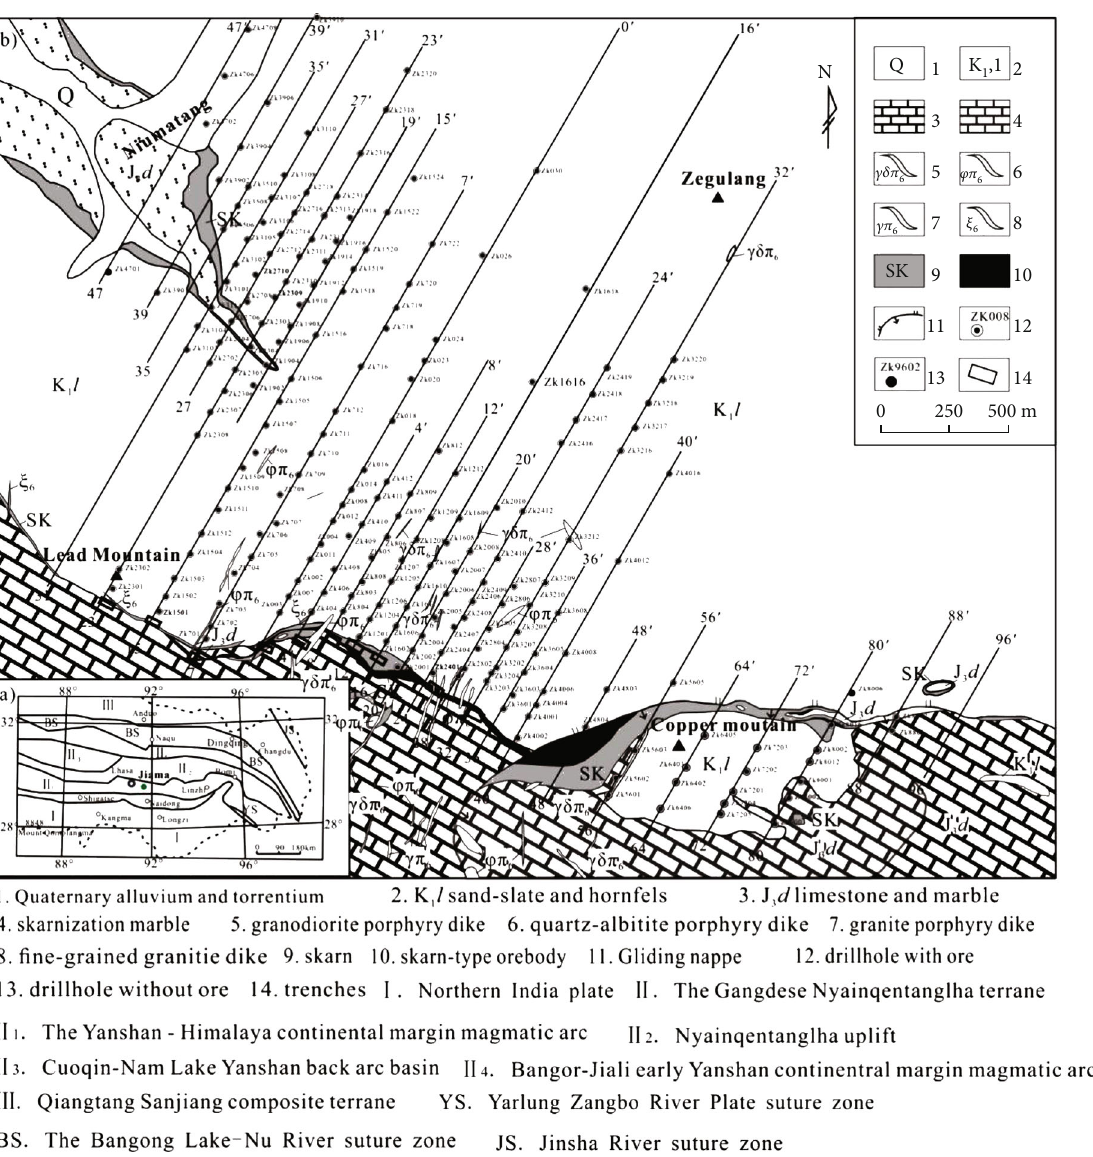
Figure 1: Geological maps of (a) the geo-tectonic background of the region surrounding Jiama and (b) the Jiama polymetallic deposit (modi fi ed from [23, 28, 29,